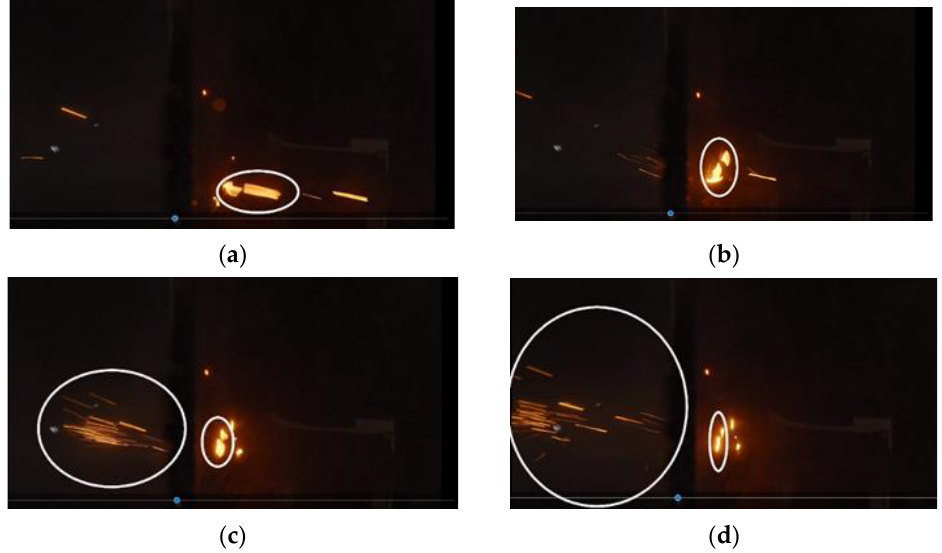
Figure 11. Shattering process, ( a ) two approaching firebrands, ( b ) two firebrands hit the mesh and producing tiny secondary firebrands, ( c ) generated tiny secondary firebrands, and ( d ) movement of tiny secondary firebrands and the change of the sizes of the two original firebrands (Stainless Steel Wire and Mesh Pty Ltd. [17]).